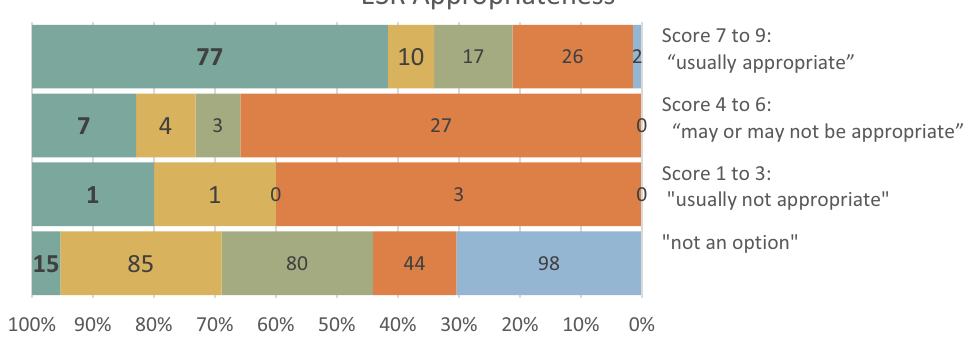
Fig. 2 ESR iGuide appropriateness scores for different CT tests (chest–abdomen, abdomen, chest, chest–abdomen–pelvis, abdomen–pelvis)